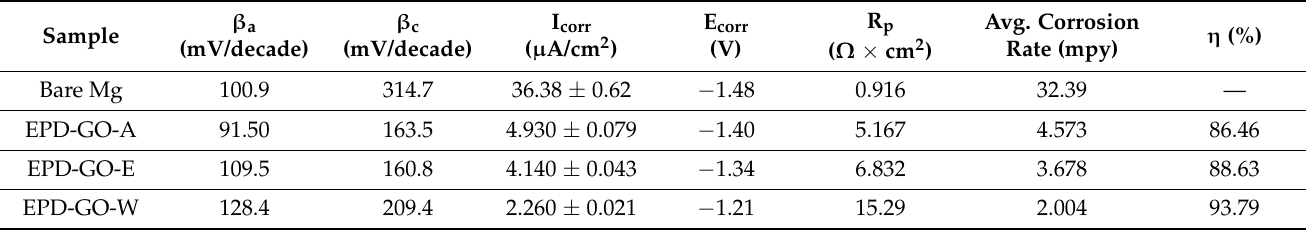
Figure 6. ( a ) Tafel curves and ( b ) I corr and R p values graph of uncoated and EPD-GO-coated Mg samples. Table 1. Kinetic parameters obtained from Tafel